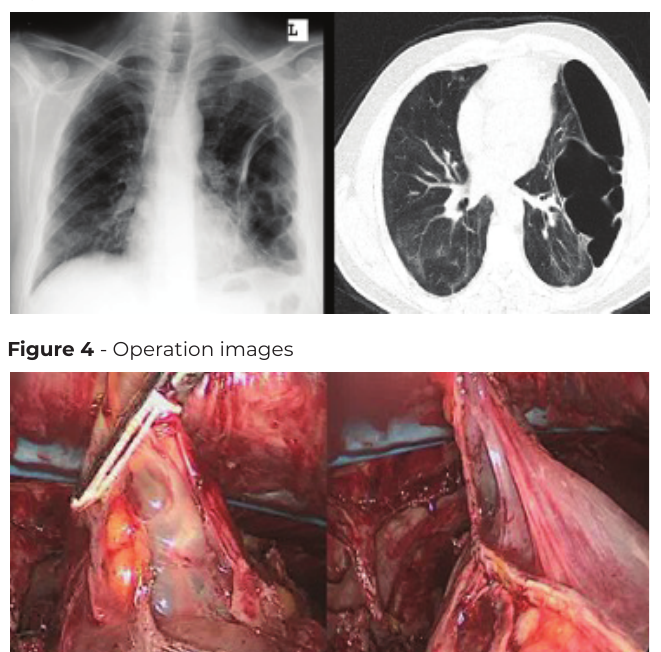
Figure 3 - Thorax bt and paac graphs taken in the 5th month